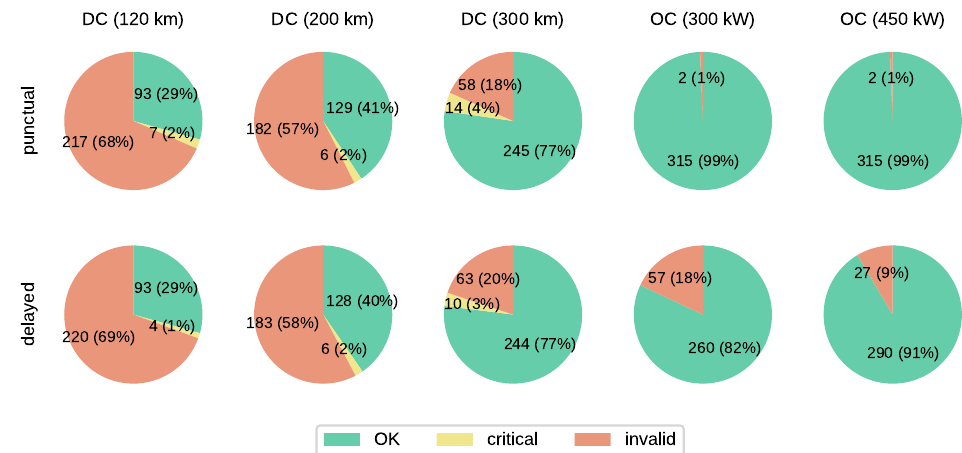
Figure 9. Results from the simulation of existing diesel bus schedules with electric buses. The pie charts indicate the number of schedules for which the following applies: Green—schedules can be served within the state of charge (SOC) limits of the battery and also leave an operational safety margin of 10 km; yellow—schedules can technically be operated, but violate the 10 km safety margin; red—schedules are inoperable because they violate the SOC limits of the